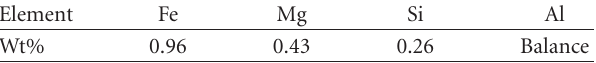
Table 1: Compositions commercially pure Aluminium. Element Fe Mg Si Al Wt% 0.96 0.43 0.26 Balance